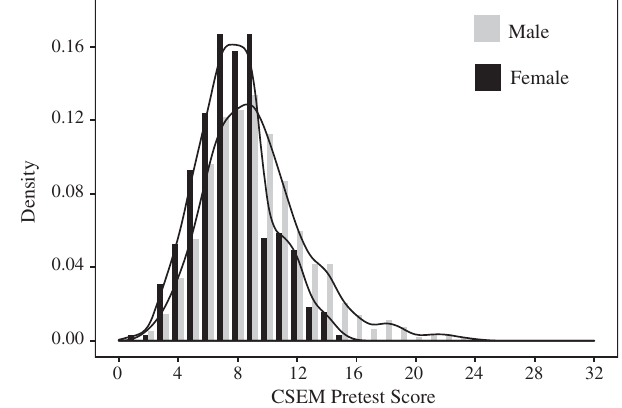
FIG. 1. The distribution of CSEM pretest scores for male and female students. Density plots are drawn for men and women; the male plot reaches its maximum to the right of the maximum of the female plot. The male and female histograms are displaced by the width of 1 bar so that the histograms do not overlap. The density plots are not displaced.